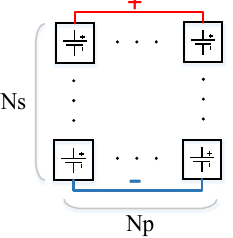
Figure 1. DC-RNG structure and components: ( a ) symbol guide, ( b ) structure.